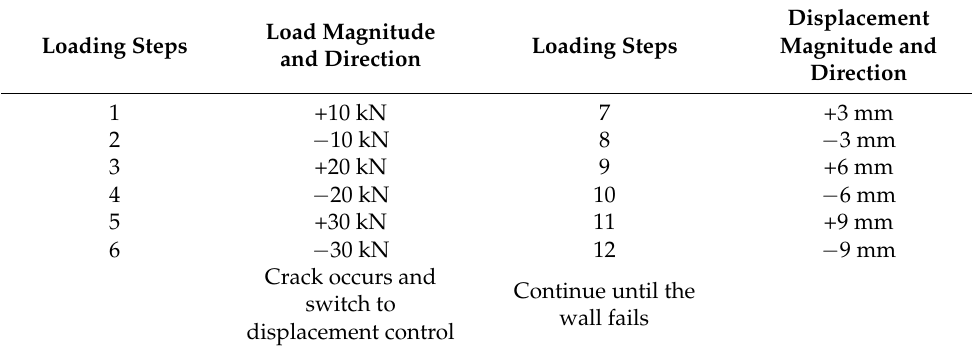
Table 3. Loading